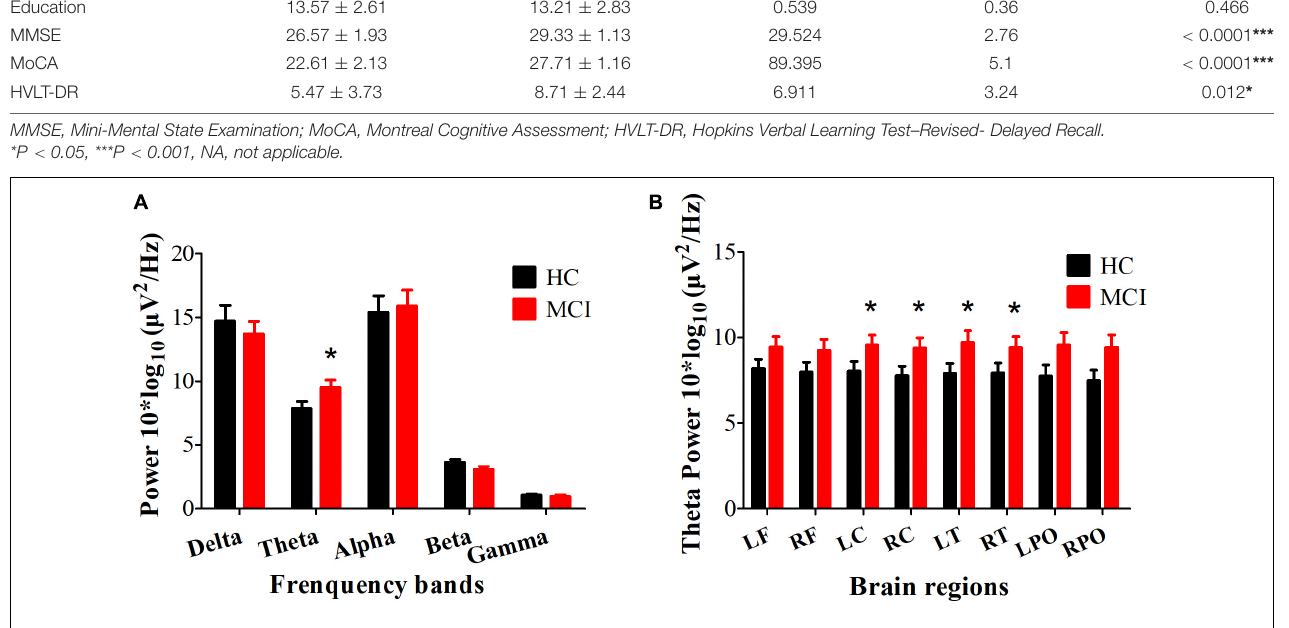
FIGURE 1 | Differences in the resting EEG power spectra between HC and MCI group. (A) The average absolute EEG power in 5 frequency bands in the HC (black columns) and MCI (red columns) group. The Y -axis represents power values, and the X -axis represents the frequency bands. A marked increase in power in the theta frequency was observed in the MCI group. * P < 0.05, FDR uncorrected. All data are expressed as the means ± SEM. (B) Distribution of statistically significant theta power in the HC (black columns) and MCI (red columns) group. A marked increase in power in the theta frequency was observed in the bilateral central and temporal regions. * P < 0.05, FDR uncorrected. All data are expressed as the means ± SEM. LF, left frontal lobe; RF, right frontal lobe; LC, left central area; RC, right central area; LT, left temporal lobe; RT, right temporal lobe; LPO, left parieto-occipital lobe; RPO, right parieto-occipital